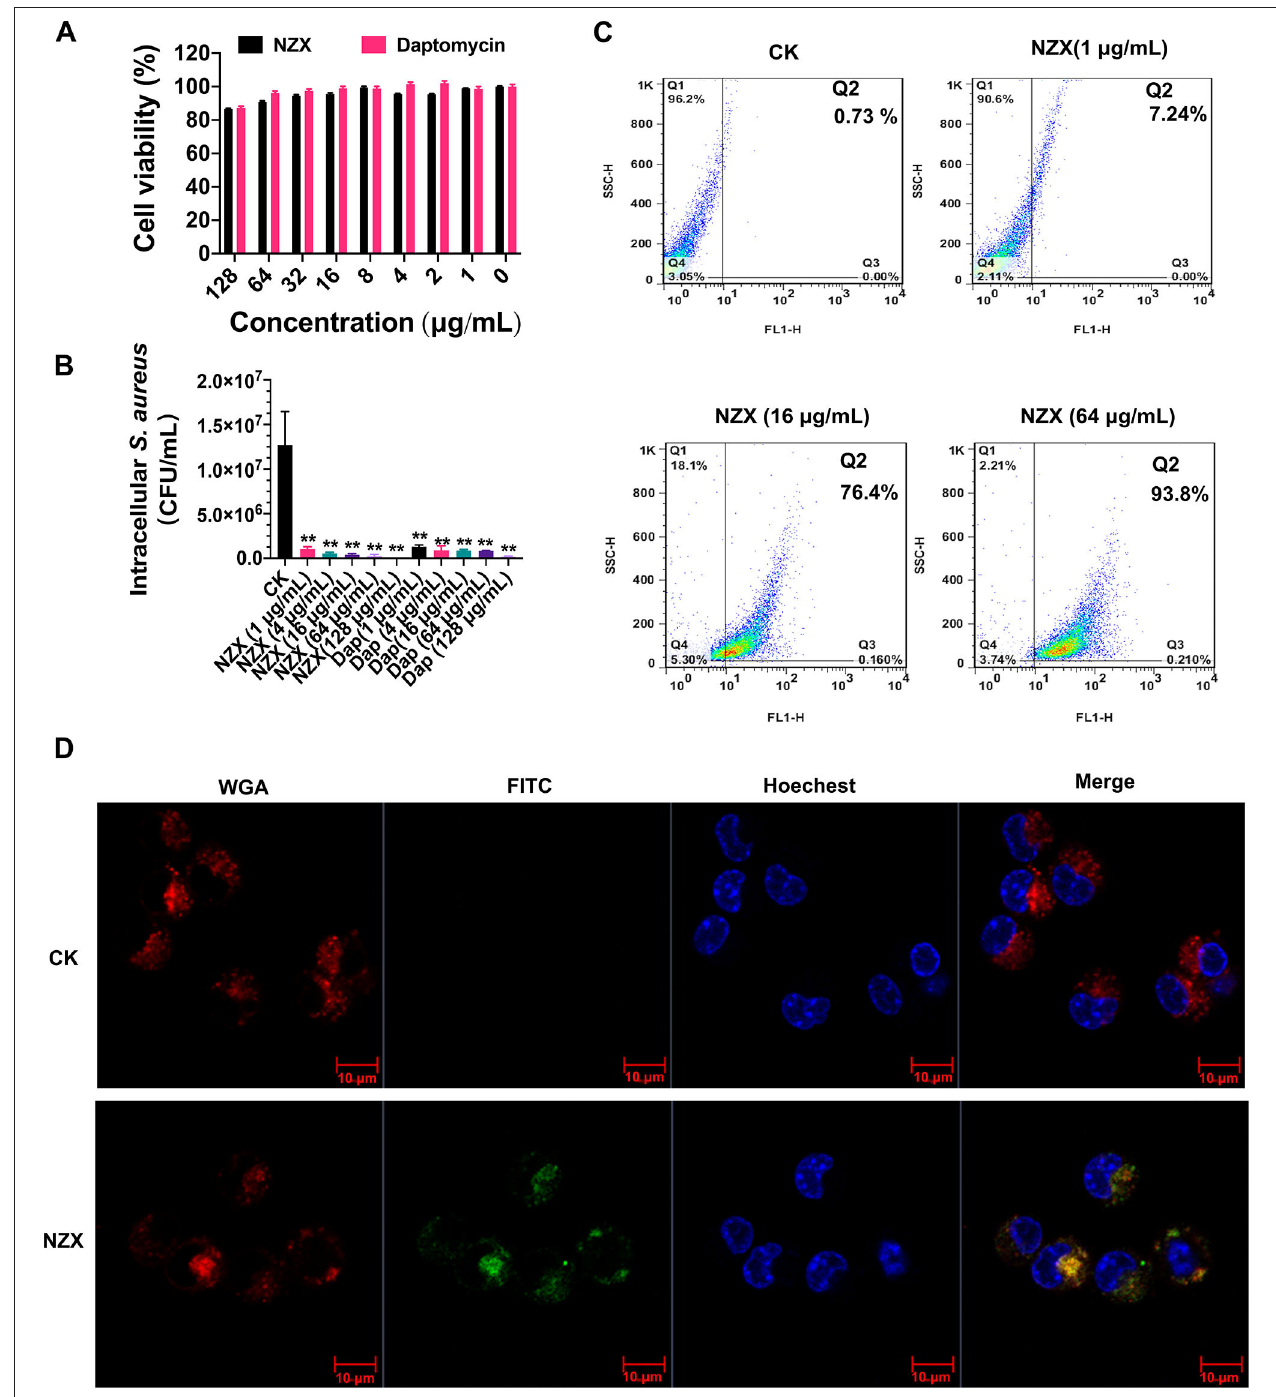
FIGURE 3 | Cell toxicity, intracellular antibacterial activity, cellular uptake, and distribution of NZX in RAW 264.7 cells. (A) Cell viability of RAW 264.7 cells incubated with NZX with concentrations ranging from 1 to 128 µ g/ml for 24h by the MTT method. Daptomycin was set as a positive control. Results from three experiments were expressed as means ± SD ( n = 3). (B) Intracellular antibacterial activity of NZX in RAW 264.7 cells infected with S. aureus E48. The activity of NZX and daptomycin against intracellular S. aureus E48 in RAW 264.7 cells was measured after treatment for 24h. CK: without the presence of any antibacterial agents. (C) Cellular uptake of FITC-labeled NZX. The cells were incubated with 1-, 16-, and 64 µ g/ml FITC-labeled NZX for 24h. The internalization ratio of intracellular FITC-labeled NZX was determined by setting quadrants on the flow cytometry. (D) FITC-labeled NZX distribution in RAW 264.7 cells. The cells were incubated with 64 µ g/ml FITC-labeled NZX for 24h. The localization of FITC-NZX was visualized by confocal microscopy. CK: free FITC without conjugated to NZX. The cells incubated with FITC-NZX presented a green signal; the cell nucleus and membrane were stained with Hoechst 33342 (a blue signal) and wheat germ agglutinin (WGA)-Alexa Fluor ® 555 (a red signal),